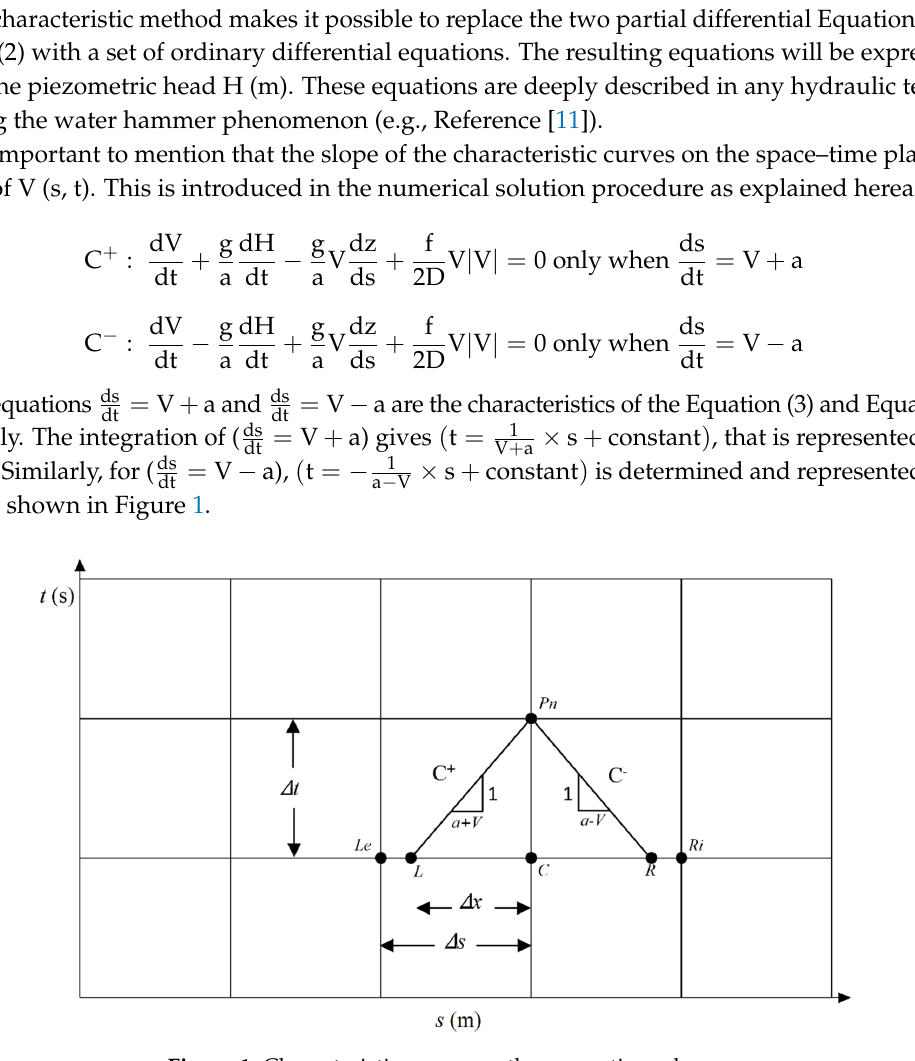
Figure 1. Characteristic curves on the space–time plane.